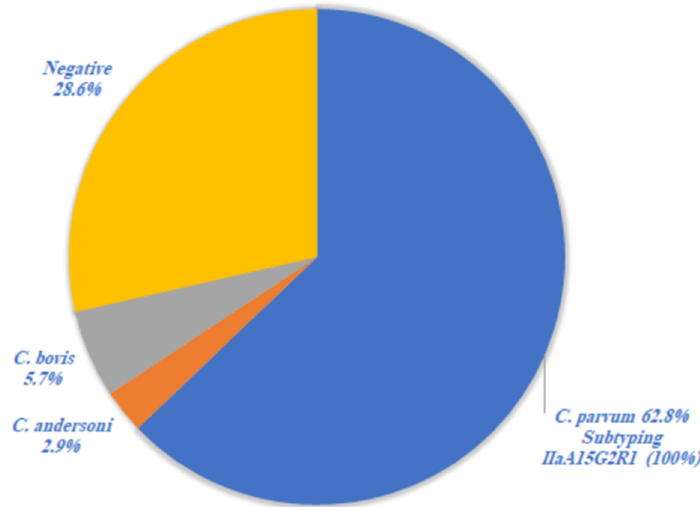
Figure 2. Cryptosporidium spp. identified by RFLP analysis in positive IC samples (No. 35) and subtyping of C. parvum at gp60 locus.